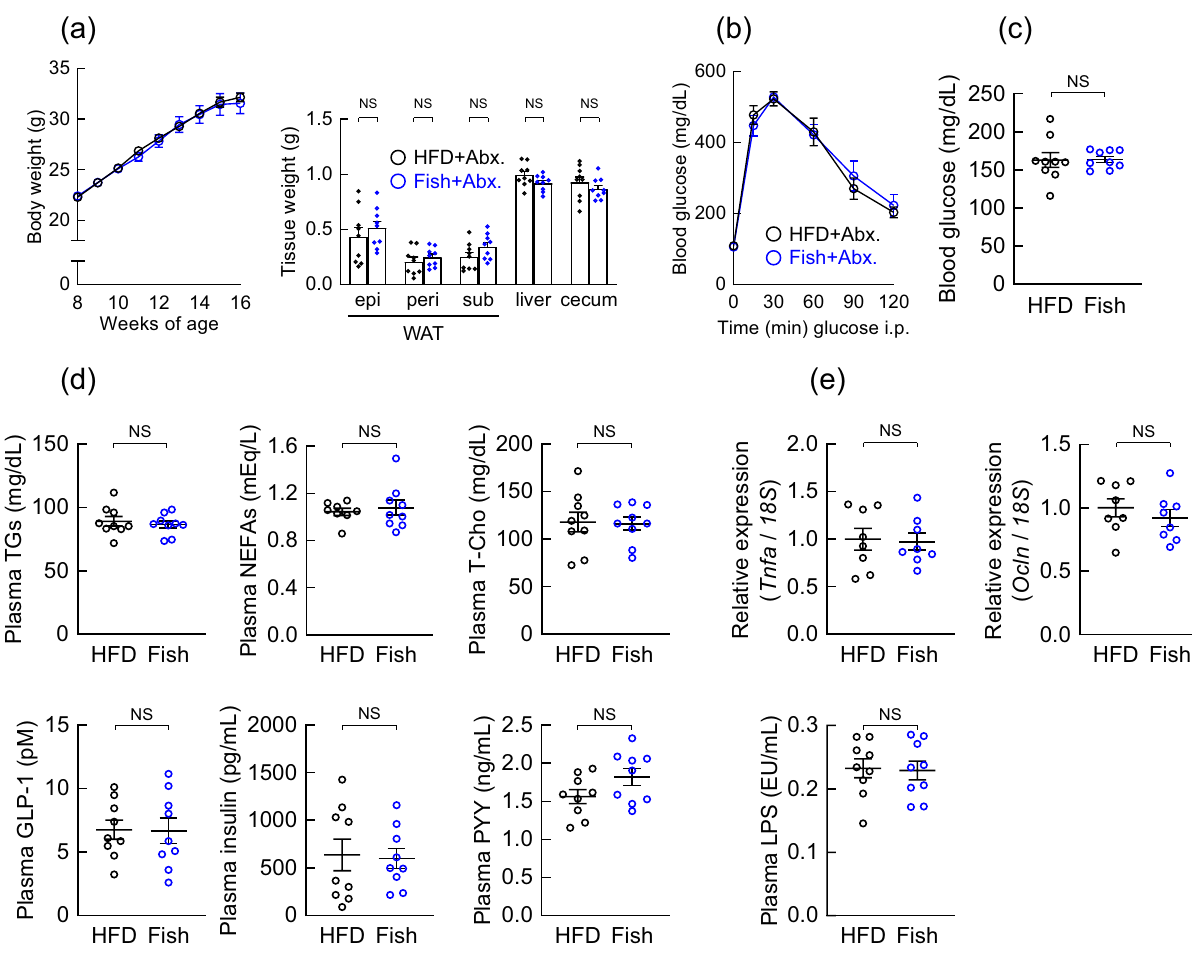
Figure 5. Fish oil improved metabolic conditions were attenuated in antibiotic-treated mice. ( a–e ) C57BL/6J male mice were fed either a high fat diet (HFD) or a modified HFD diet (Soybean oil in HFD was replaced with fish oil (Fish)) and treated with antibiotics (Abx.) for 8 weeks. ( a ) Changes in body and tissue weights. epi epididymal, peri perirenal, sub subcutaneous, WAT white adipose tissue. ( b ) ipGTT was evaluated at 15 weeks of age. ( c,d ) After 5 h fasting, blood glucose, plasma triglycerides, non-esterified fatty acids, total cholesterol, GLP-1, insulin, and PYY levels were measured at the end of the experimental period. ( e ) The mRNA expression of Tnfα and Ocln in the colon ( upper panel ) and plasma LPS levels ( lower panel ) were measured at the end of the experimental period (n = 7–9 mice for each group). Results are presented as means ± standard error. NS not